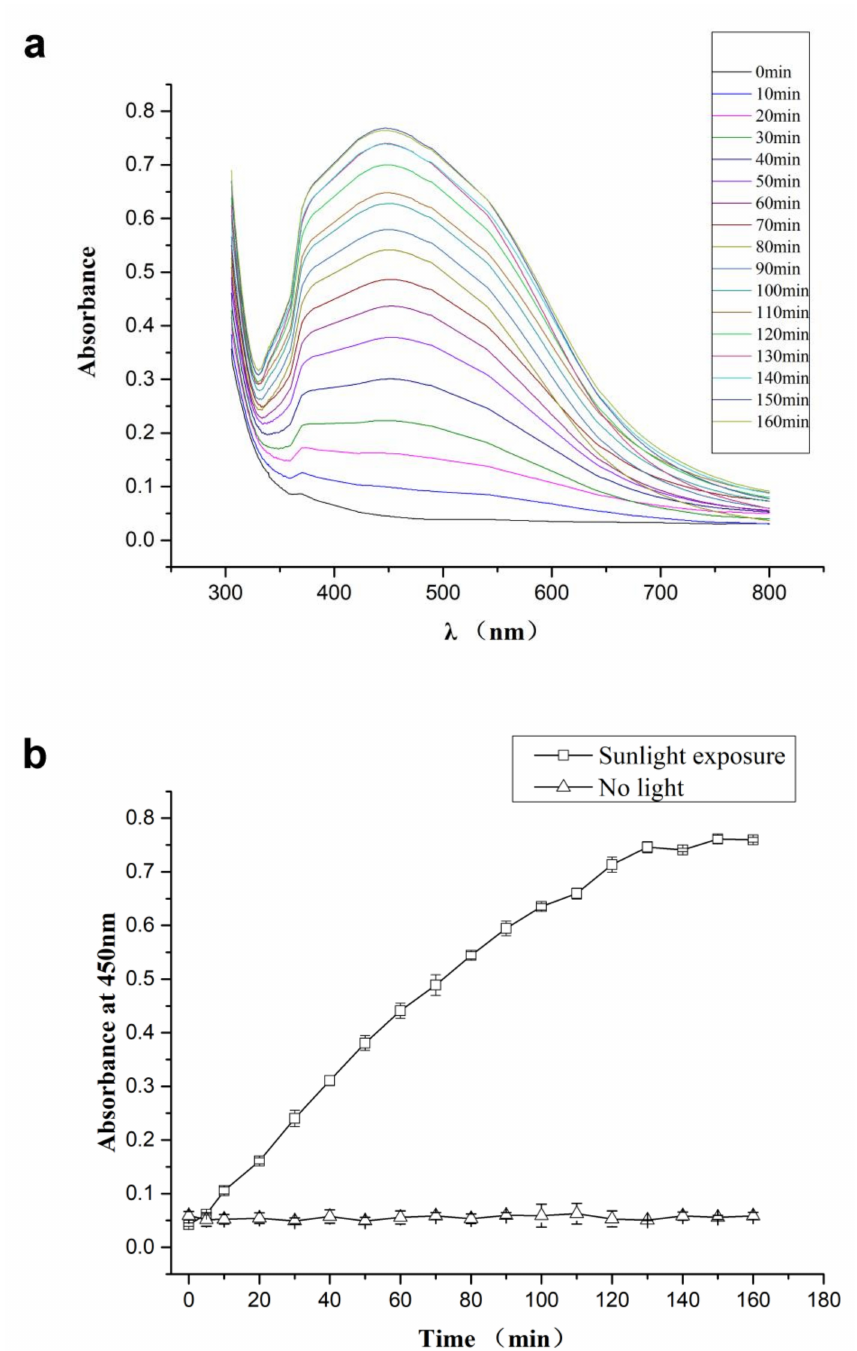
Figure 1. The UV-vis absorption of CMC-SNs (sodium-stabilized silver nanoparticles). ( a ) Absorption curves at di ff erent times. ( b ) The curve of time and absorption at 450